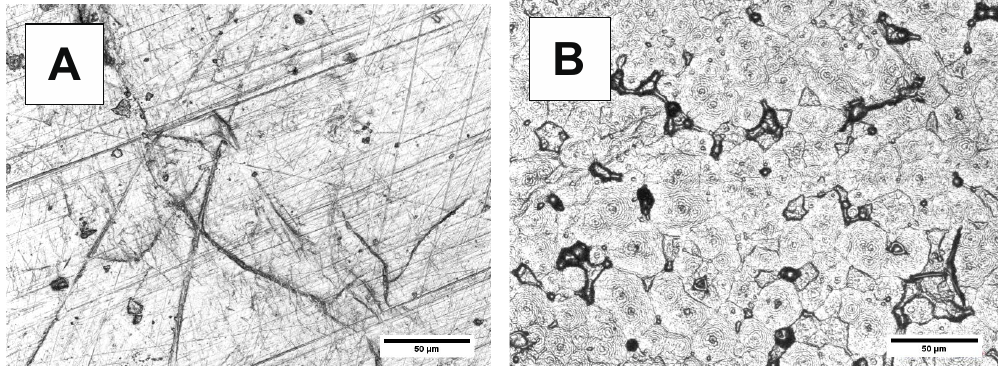
Figure 13. LSM micrographs of PBS-DLS 50:50 films ( A ) before and ( B ) after 24 days of degradation.